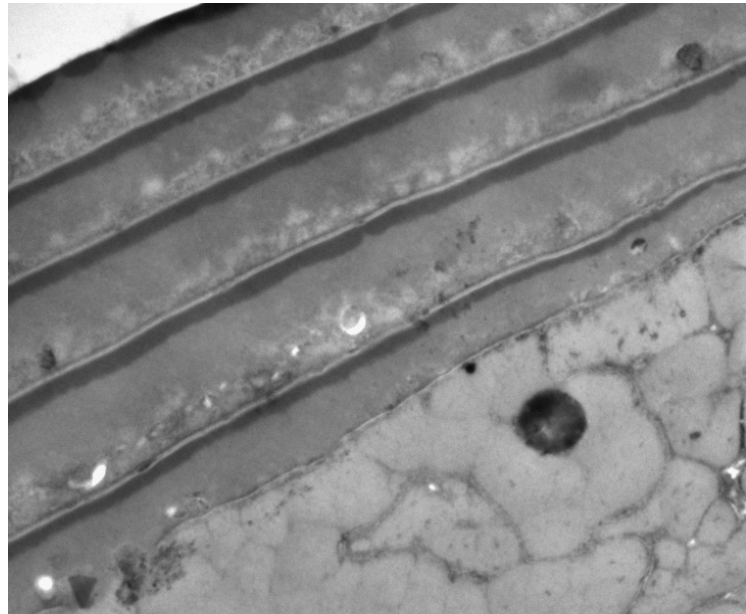
Figure 2. TEM of cross-section of human hair with five overlapping cuticle cells. Each cell has a dense A-layer and a less dense exocuticle beneath. The lower layer is endocuticle. ×35,000 The layer closest to the upper surface of each cuticle cell is the densely-stained A-layer then the exocuticle and beneath that the endocuticle.